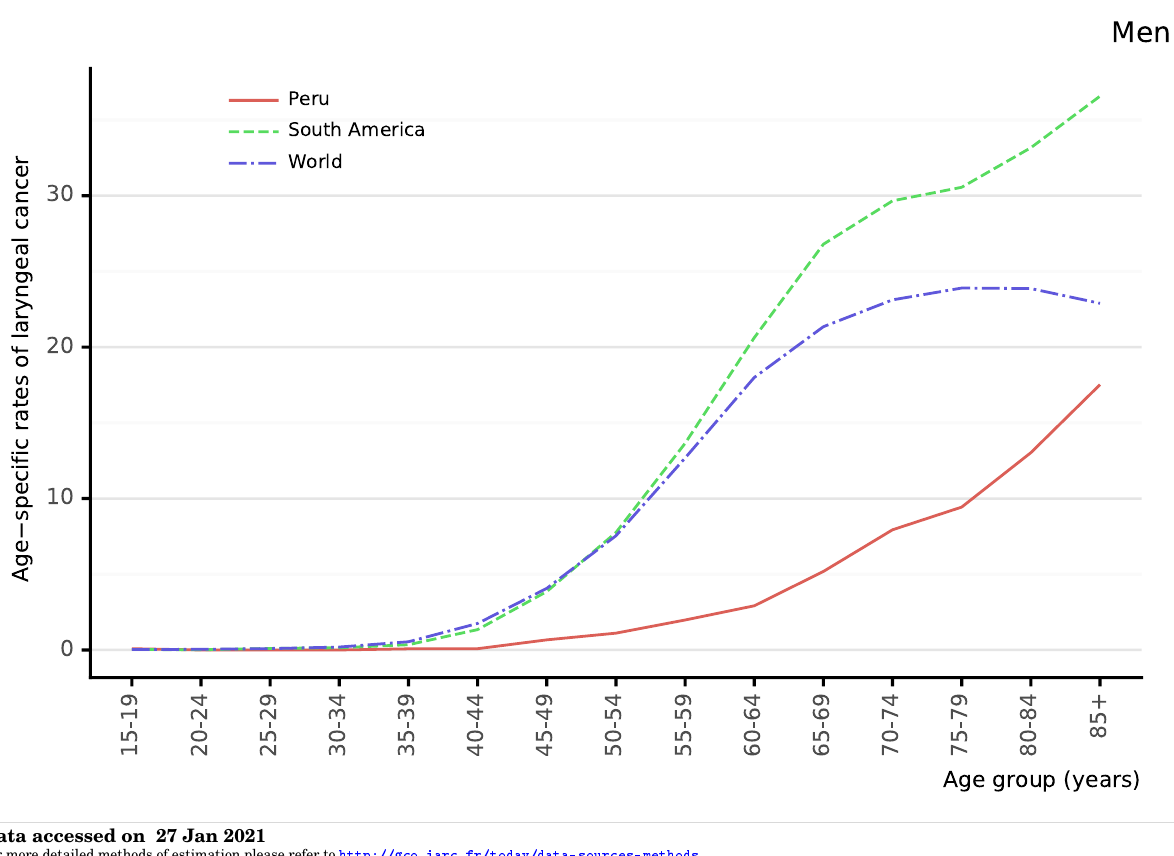
Figure 103: Comparison of age-specific laryngeal cancer incidence rates among men by age in Peru, within the region, and the rest of